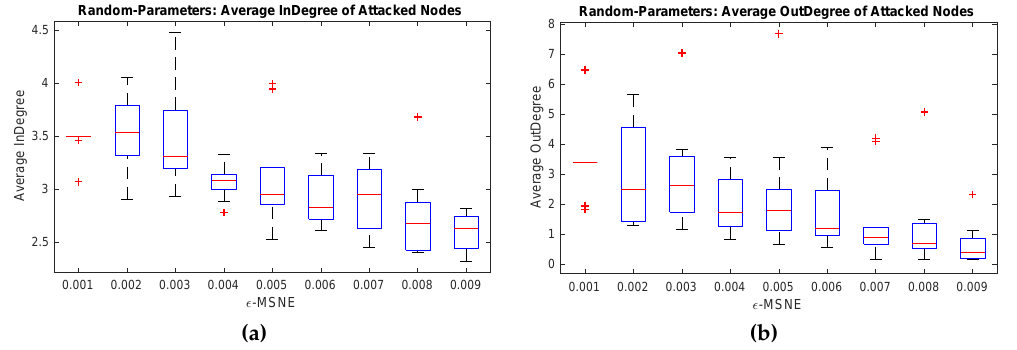
Figure 8. Attacker’s (cid:101) -MSNE Strategy vs. Node Degrees. Average indegree ( a ) and outdegree ( b ) of nodes potentially attacked in terms of the (cid:101)